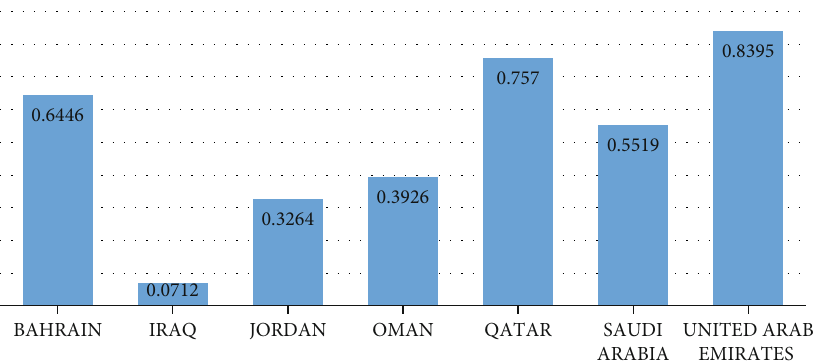
Figure 2: Bar chart of percentage of person completely vaccinated against COVID-19 in the Arabian Peninsula